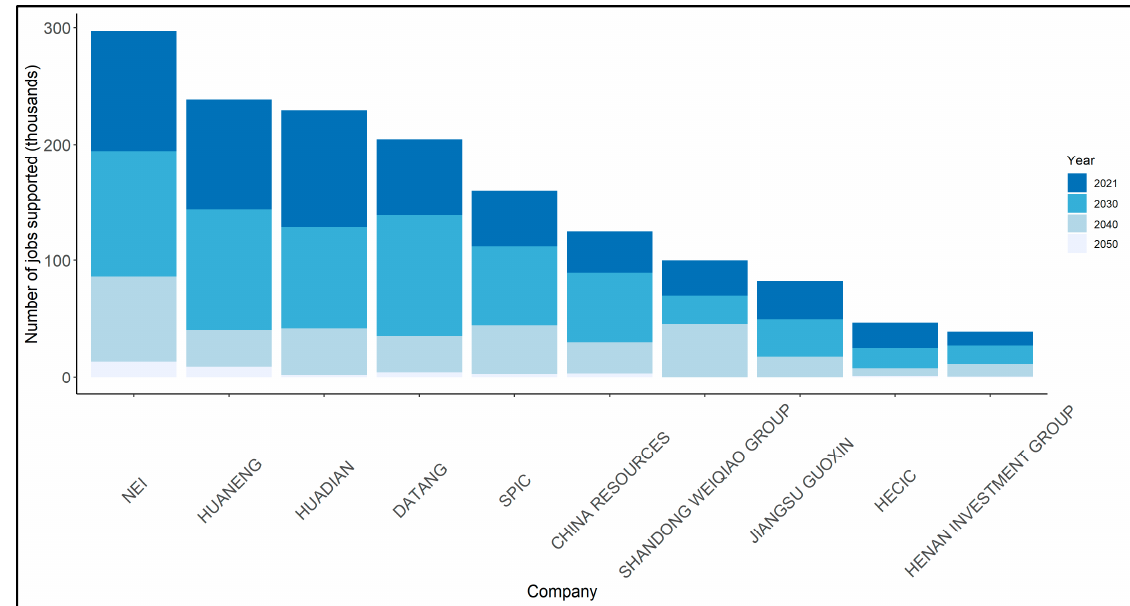
Figure 8. Largest parent companies by number of coal jobs supported, 2021–2050 (baseline scenario). Unsurprisingly, the Big Five are also the largest contributors (directly and indirectly) to tax revenues nationally (see Figure 9), with the activities of the two largest, NEI and Huaneng, generating CNY 39.4 billion and CNY 33.3 billion in revenue respectively, and the ‘Big Five’ together, almost CNY 140 billion. The largest ten firms contribute almost CNY 175 billion between them, representing more than half of total tax revenues from thermal coal. Mirroring the national trajectory, total tax contributions from the ‘Big Five’ decline relatively slowly at first, falling just 13% to CNY 121.2 billion in 2030, then start to fall much more rapidly after 2034, falling by 60% from their 2021 levels to just CNY 55.2